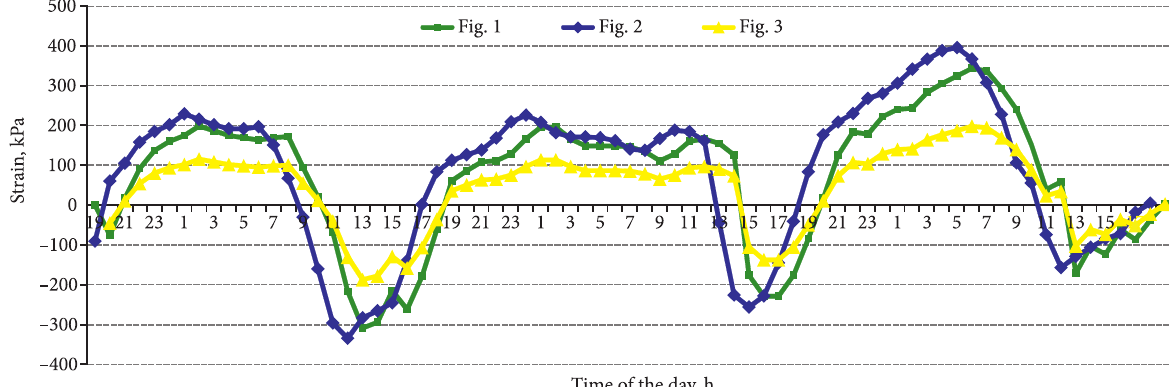
Fig. 16. Mode of deformation for the upper asphalt concrete layer – stresses during the days with max positive temperatures (schemes in Figs